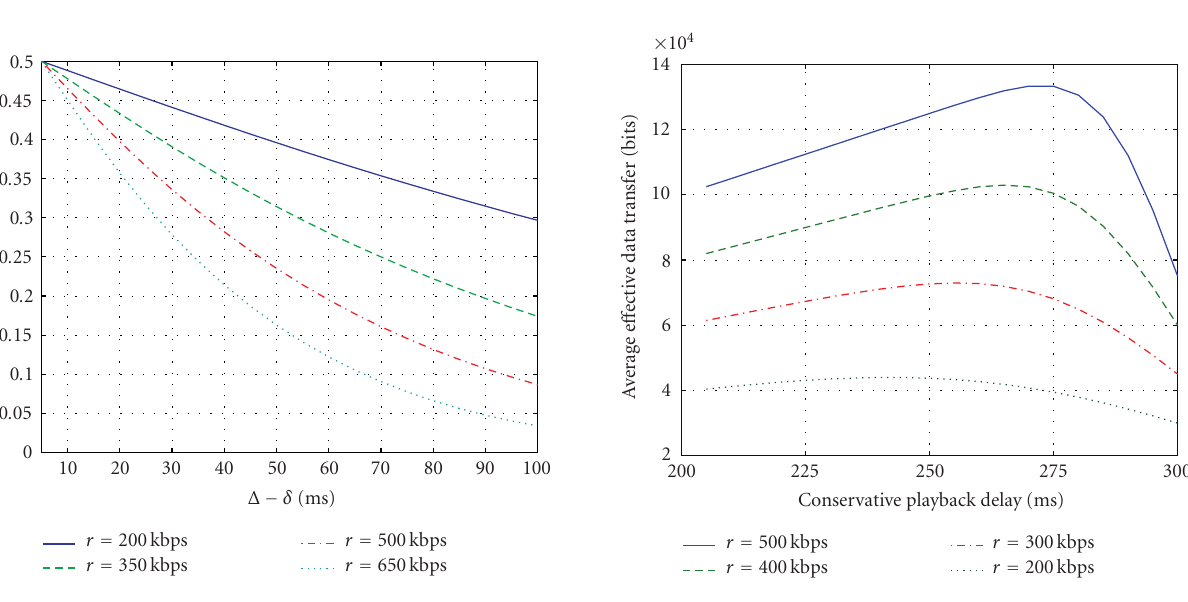
Figure 3: Average probability of late packets ( Δ = 300ms). Figure 4: E ff ective average data transfer ( Δ =